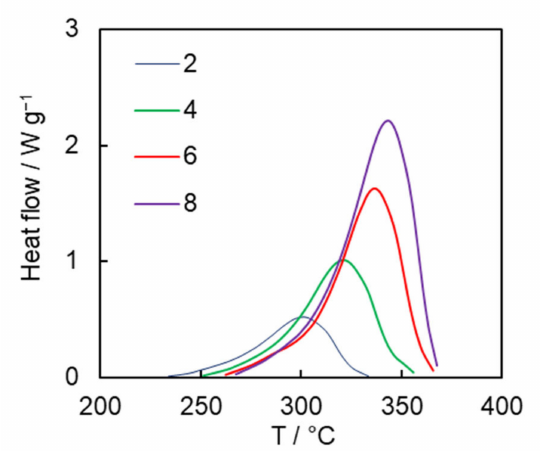
Figure 3. DSC curves for dicyanate ester polymerization (numbers denote heating rates in ◦ C min − 1